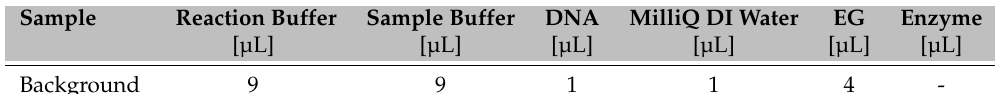
Table A4. Mixture used for background signal measurement.